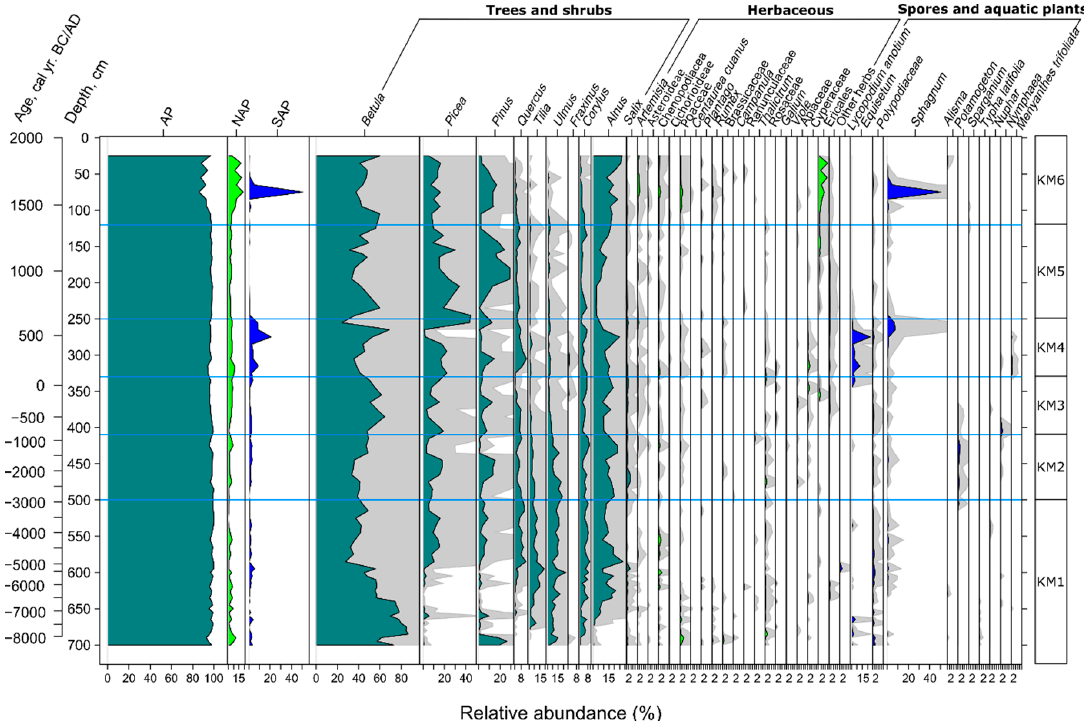
Figure 5. Diagram of pollen and spore in the deposits of the Krivetskiy Mokh mire (AP—arboreal pollen (blue-green), NAP—non-arboreal pollen (green), SAP—spores and aquatic plants (blue); KM1–KM6—the zones defined based on the main developmental stages of the mire). Grey polygons show percentage values magnified by ten.